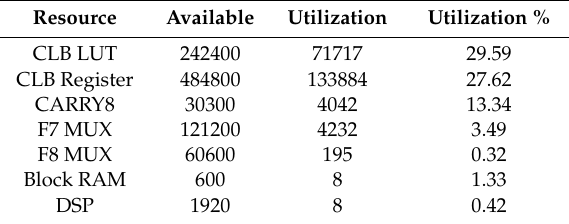
Figure 10. Schematic for a group of 256 correlators. Table 1. Device Utilization for 2304 Correlators Implemented in XCKU040 Device.